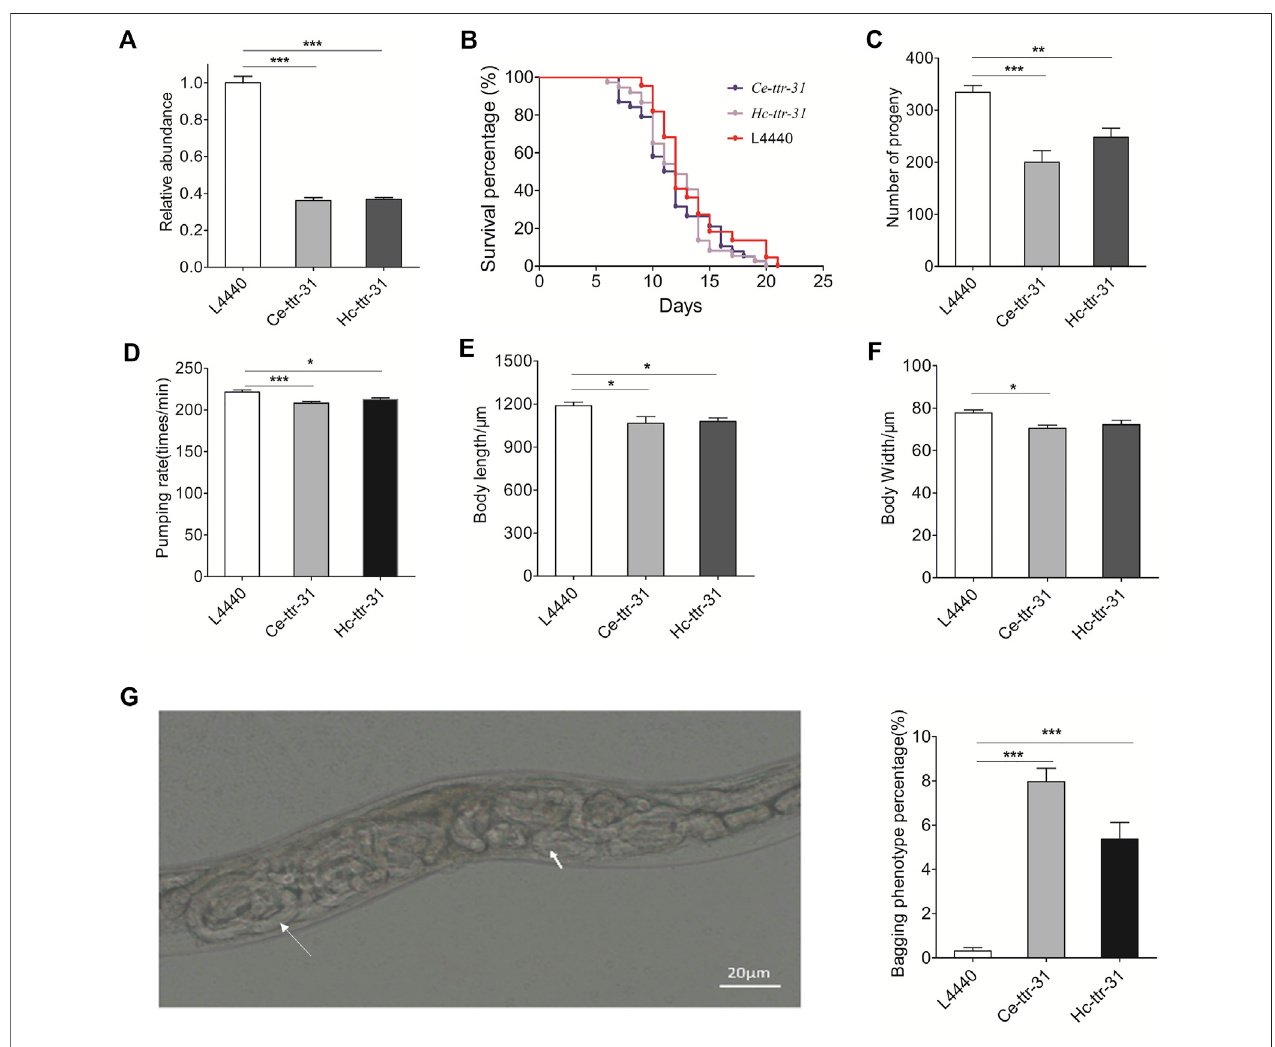
FIGURE 5 | Hc-ttr-31 RNAi mediated gene knockdown of Ce-ttr-31 in Caenorhabditis elegans . (A) Transcriptional levels of Ce-ttr-31 in treated worms. Effects of gene knockdown on the lifespan (B) , brood size (C) , pumping rate (D) , body length (E) and body width (F) are shown. Data are presented as mean ± SEM ( n (cid:2) 10). (G) Hatching in vivo phenotype and the percentage of bagging phenotype are shown. Data are presented as mean ± SEM ( n (cid:2) 6). * p < 0.05; ** p < 0.01; *** p < 0.001.